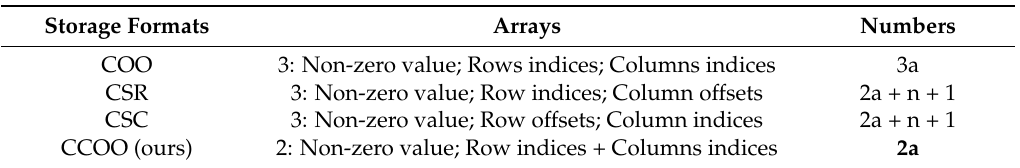
Table 4. Comparison of different sparse matrix storage formats. COO: coordinate; CSR: compressed sparse row; CSC: compressed sparse column; CCOO: compressed